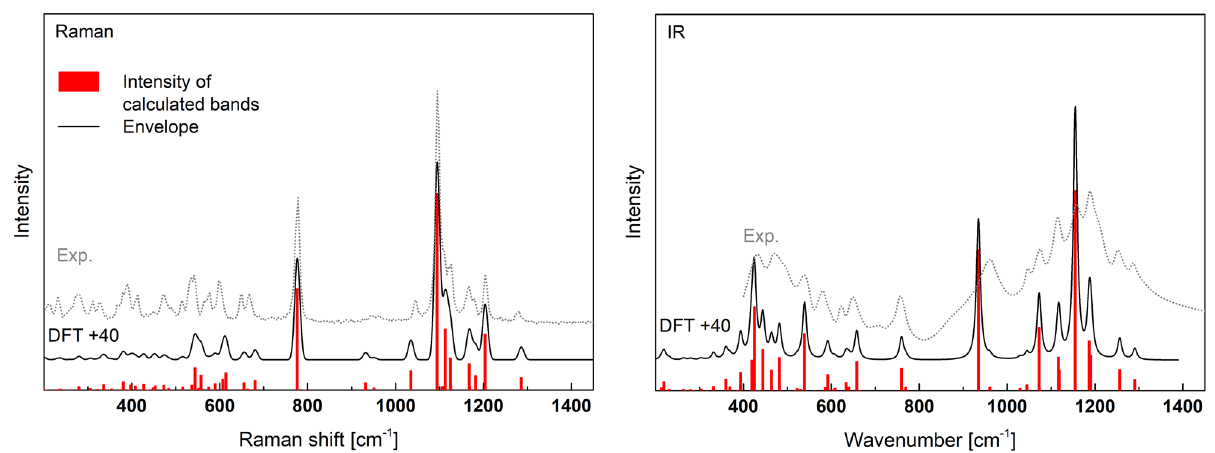
Figure 13. Calculated Raman and IR spectra of NaAlP 2 O 7 shifted by + 40 cm −1 and experimental Raman and IR spectra (Exp.) of the synthesized material.